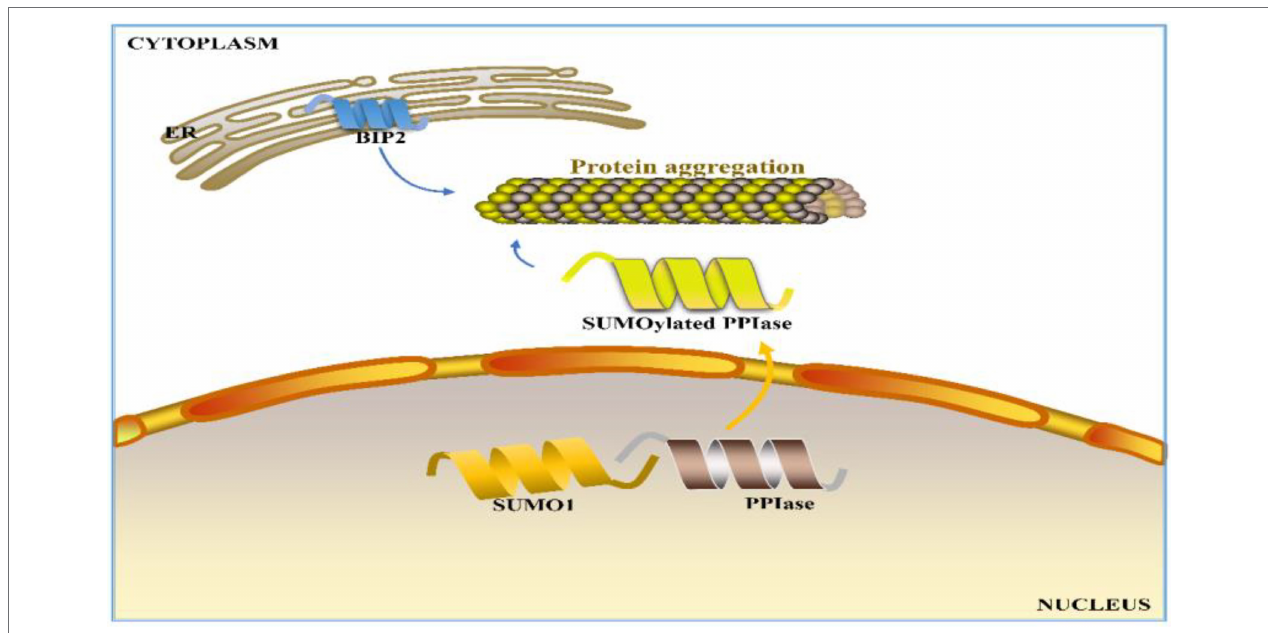
FIGURE 1 | Proposed N-regulated mechanism for wheat grain protein polymerization in the cytoplasm. ER: endoplasmic reticulum, BIP2: luminal-binding protein 2 precursor, SUMO1: small ubiquitin-related modifier 1, and PPIase: peptidyl-prolyl cis-trans